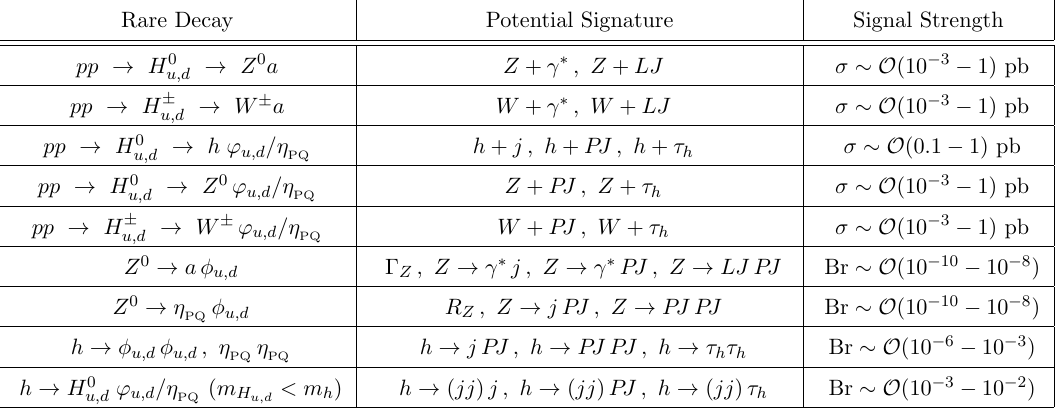
Table 2 . Compilation of rare decays that could potentially probe the model in (10.1). The middle column shows potential signatures, assuming that the MeV axion a would be tagged either as